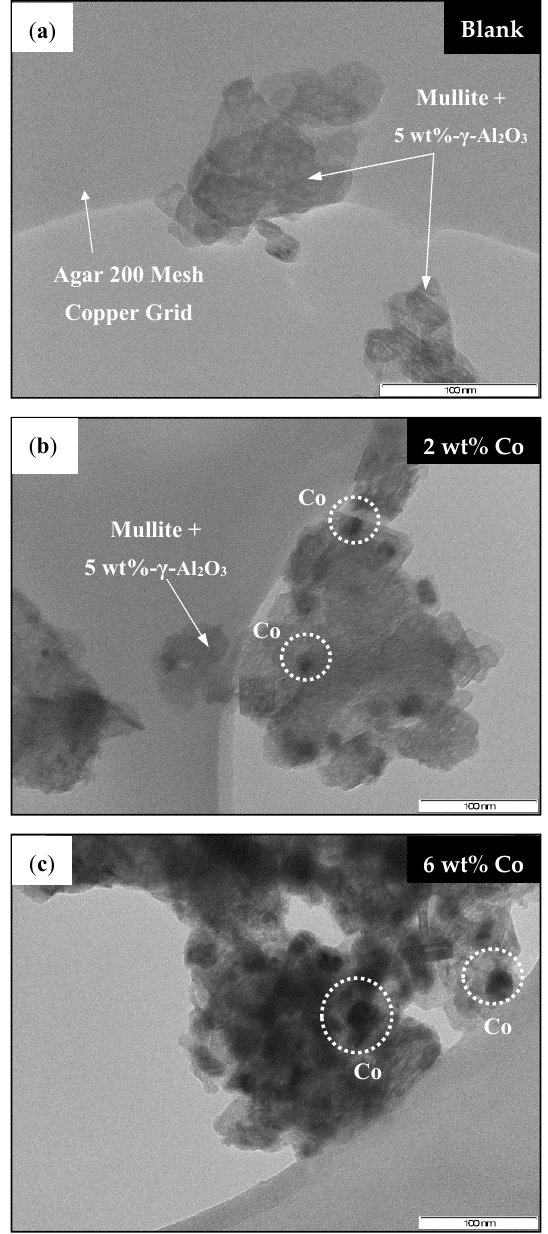
Figure 21. TEM micrographs of used catalysts; ( a ) blank, ( b ) 2 wt% Co, ( c ) 6 wt% Co. (N.B. Examples of cobalt clusters are encircled by white dashed rings).